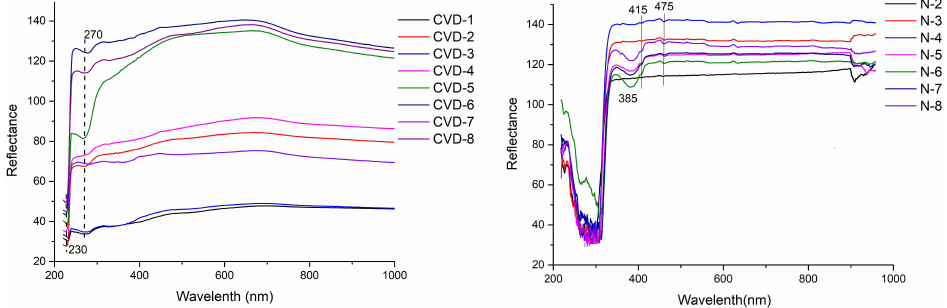
Figure 6. UV-Vis spectra of diamond samples.